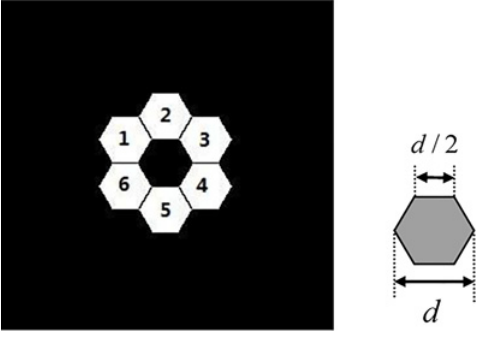
Fig 2. Construction of primary mirror and dimension of segmented sub-aperture.